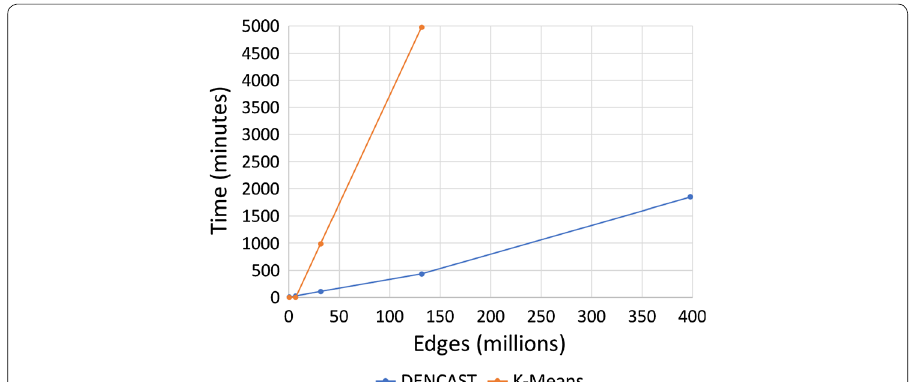
Fig. 6 DENCAST vs K-means. Running times measured with different sizes of the PVNREL dataset (100 K, 1 M, 5 M, 10 M, 20 M objects and 0.7 M, 7 M, 30 M, 130 M, 400 M edges in the neighborhood graph)